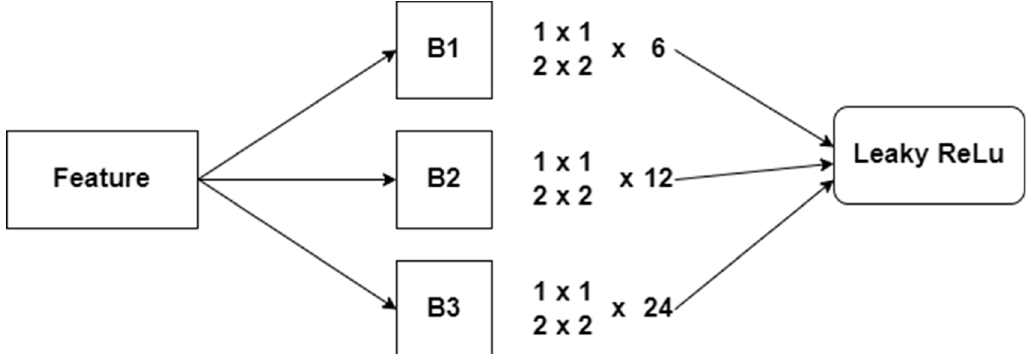
Figure 5. Fine-tuned DenseNet Architecture.